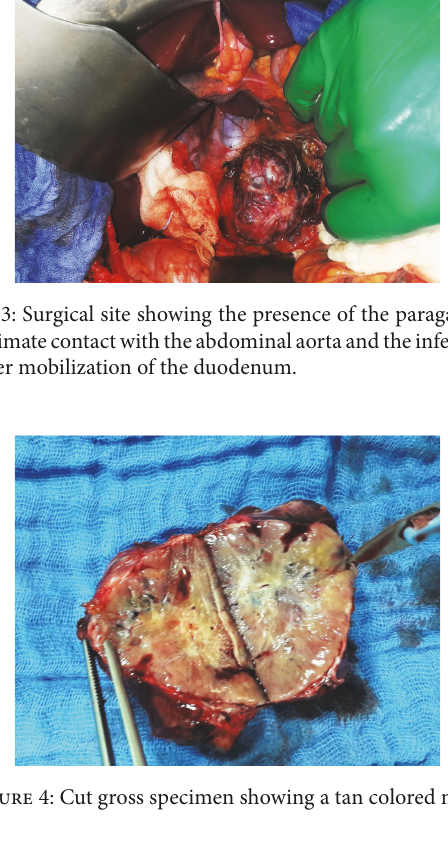
challenging, due to the variability of the clinical